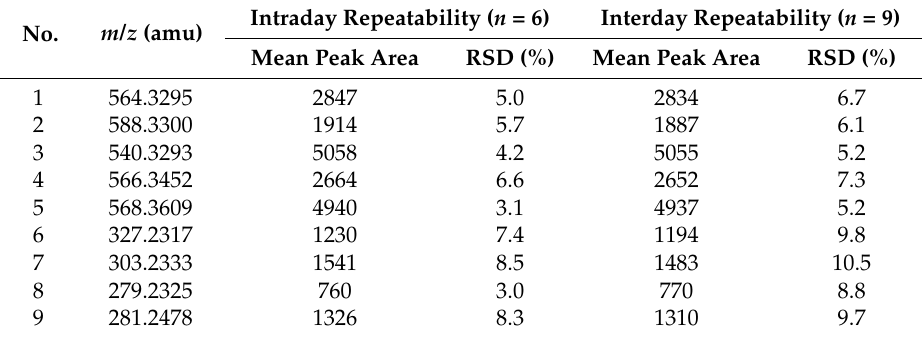
Table 2. Reproducibility testing results of the UPLC-TOF-MS profiling method.